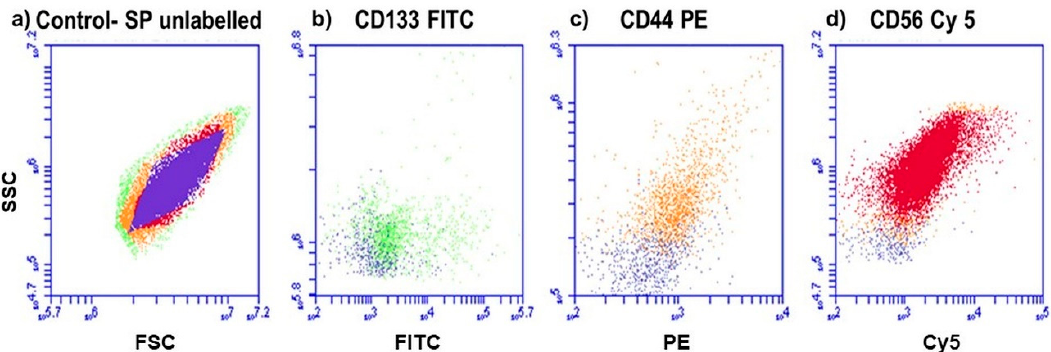
Figure 1. Fluorescence protein detection, using flow cytometry. ( a ) Control SP of cells that are unlabeled. ( b ) Lung CSCs positive for CD133 (FITC), ( c ) lung CSCs positive for CD44 (PE) and ( d ) lung CSCs positive for CD56 (Cy5). All positive samples are overlaid with the control, to distinguish between the color shifts.